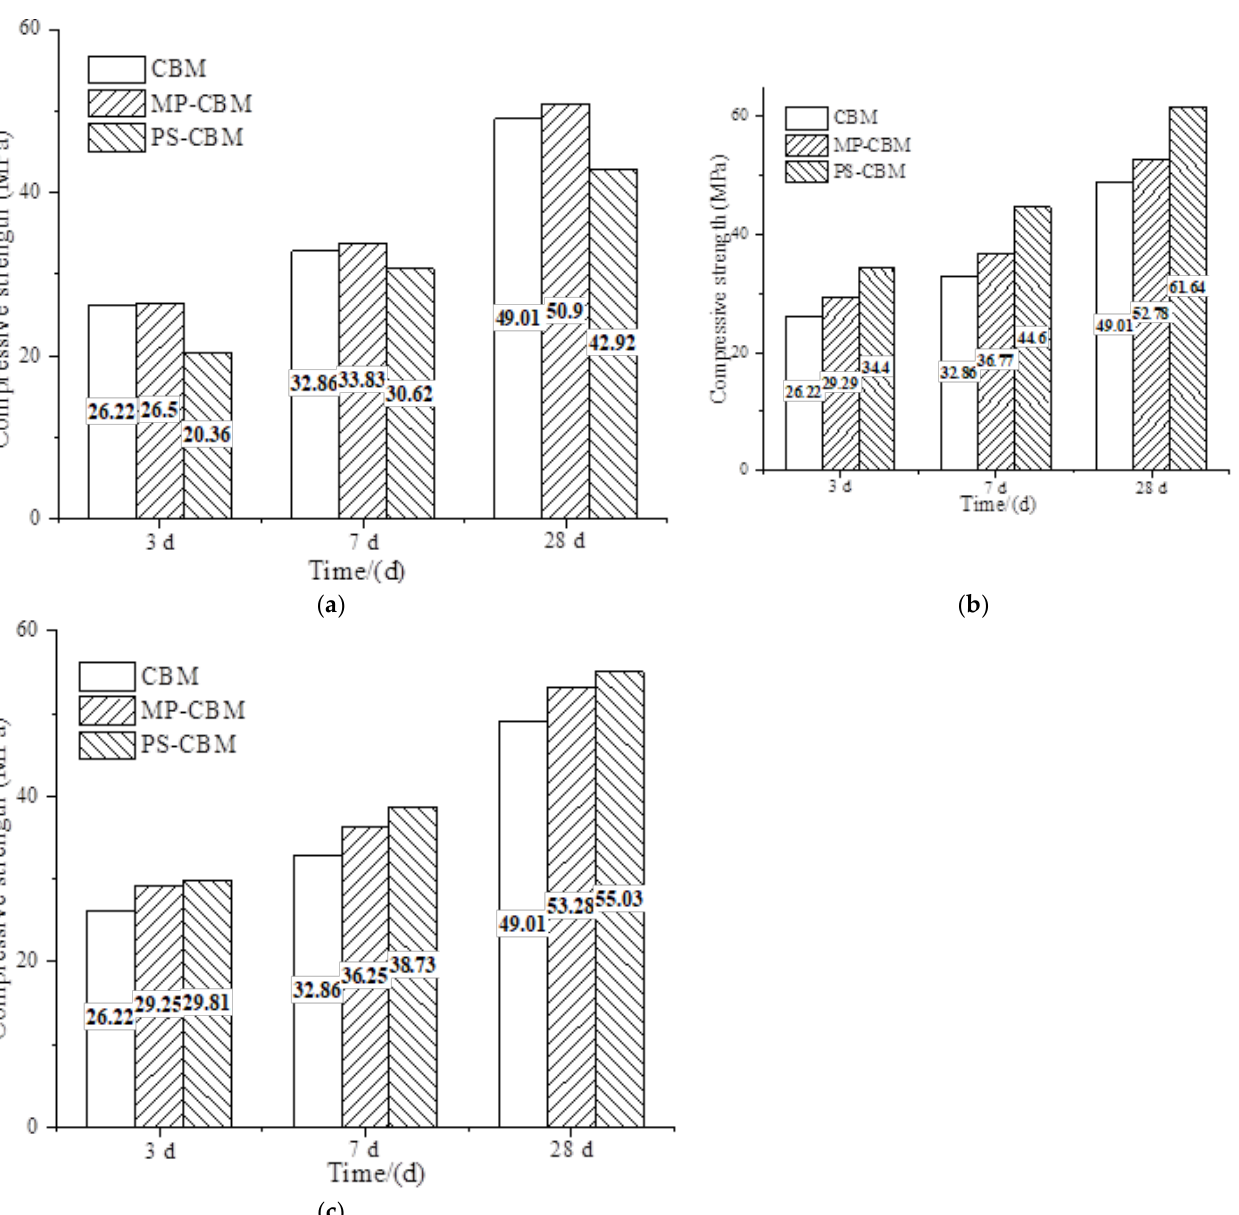
Figure 1. The influence of the alkalinity of the precursor solution on the compressive strength of cement-based materials. ( a ) NSPS pH = 4, ( b ) NSPS pH = 6, and ( c ) NSPS pH = 8.